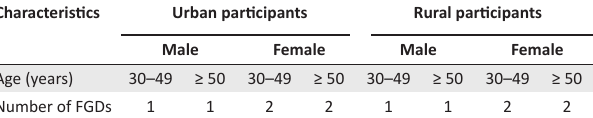
TABLE 3: Characteristics of focus group discussions of people living with human immunodeficiency virus and comorbid non-communicable diseases ( n = 72). †